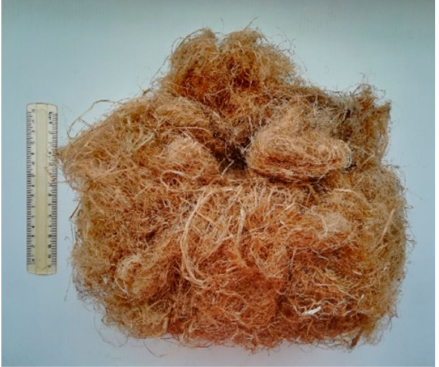
Figure 1. Hemp fibers used in the experimental program.